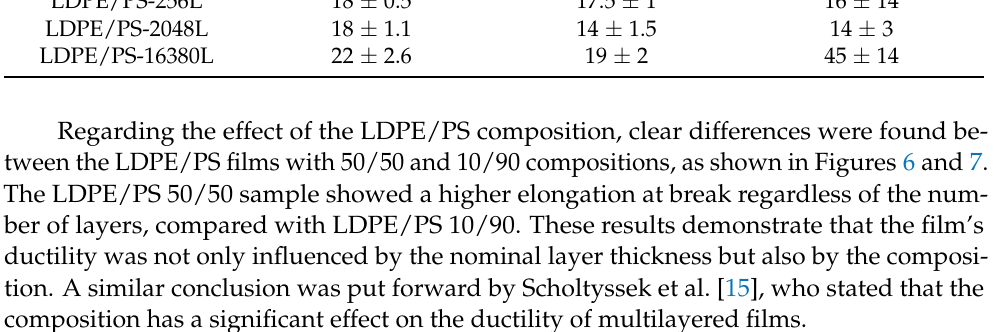
Figure 7. Engineering stress-strain plot of multilayered LDPE/PS 10/90 films (in the machine direction) with different numbers of layers. Table 6. Mechanical properties of the LDPE/PS 10/90 (wt/wt) films with different numbers of layers. Films